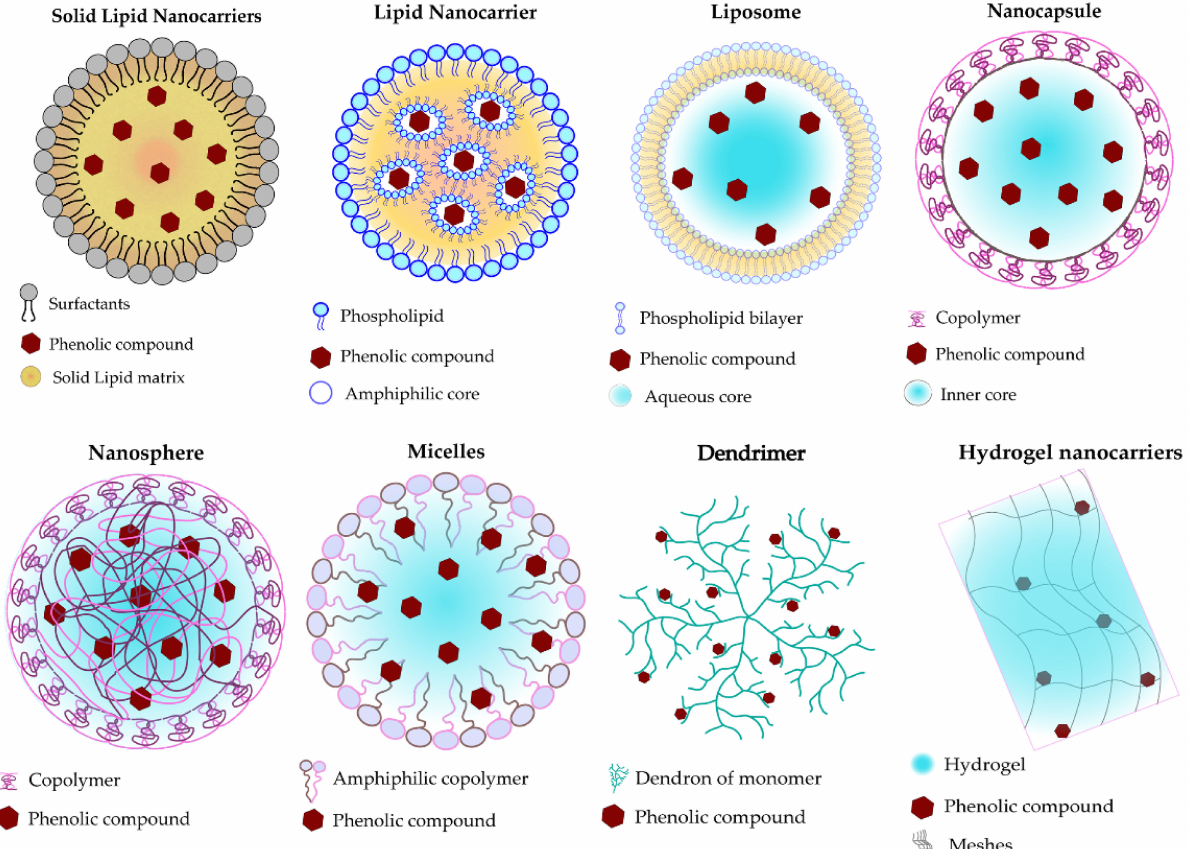
Figure 2. Schematic representation of organic nanocarriers used for loading